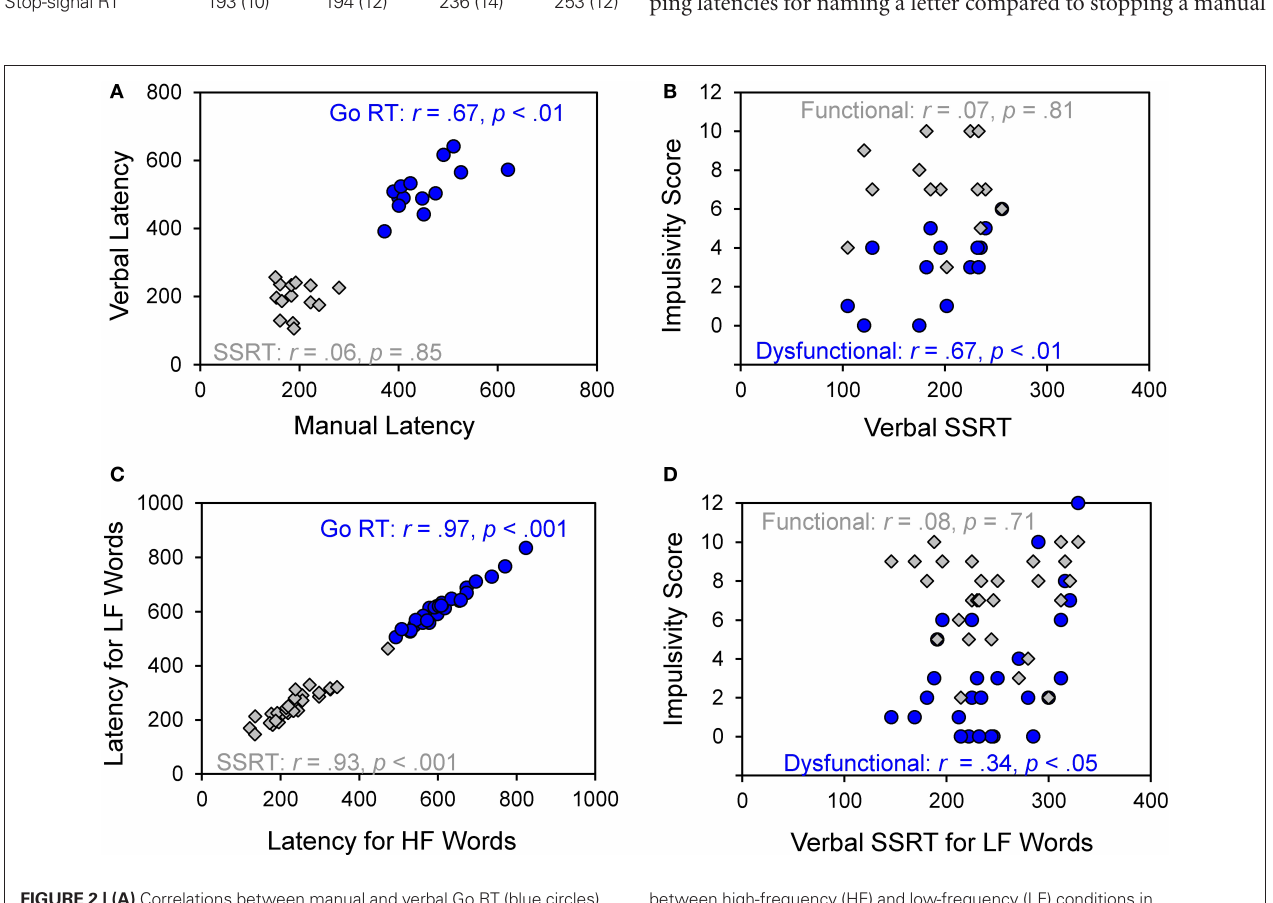
Figure 2 | (A) Correlations between manual and verbal Go RT (blue circles) and SSRT (gray diamonds) for choice responses in Experiment 1. (B) Correlations between verbal SSRT and impulsivity scores (functional scores in gray diamonds; dysfunctional scores in blue circles) in Experiment 1. (C) Correlations for Go RT (blue circles) and SSRT (gray diamonds)